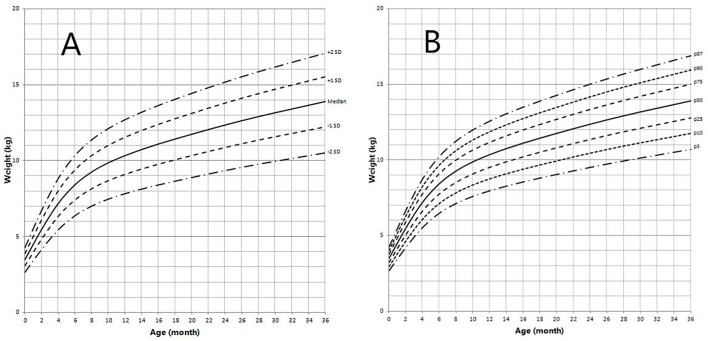
Weight in children with 5αRD (0–36 months old). (A) Standard deviation curve; (B) Percentile curve.